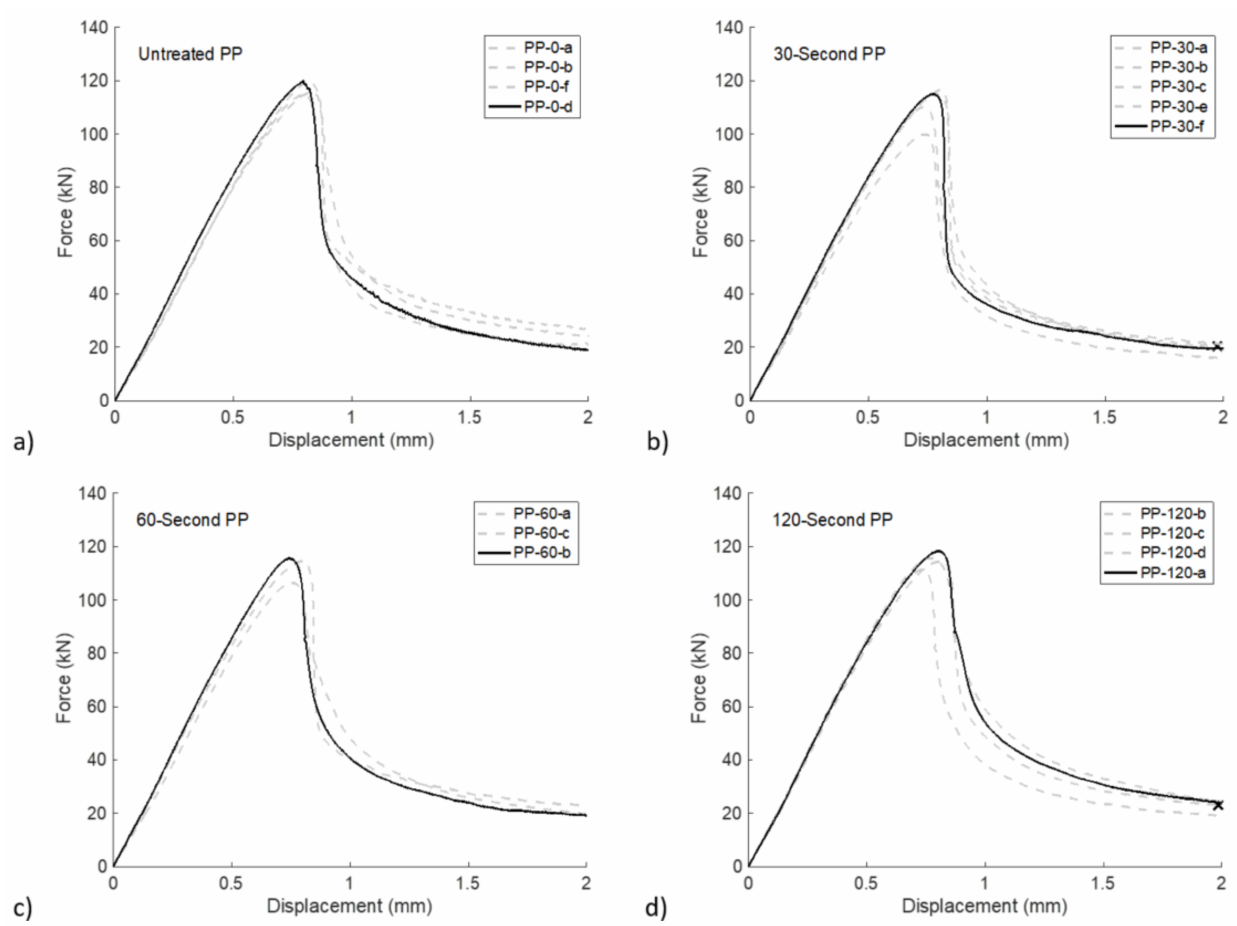
Figure A1. Force-displacement curves for all PP specimens tested in compression ( a ) 0 s of treatment time, ( b ) 30 s of treatment time, ( c ) 60 s of treatment time, and ( d ) 120 s of treatment